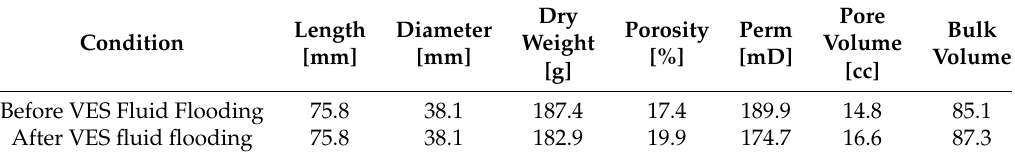
Table 4. Core properties before and after core